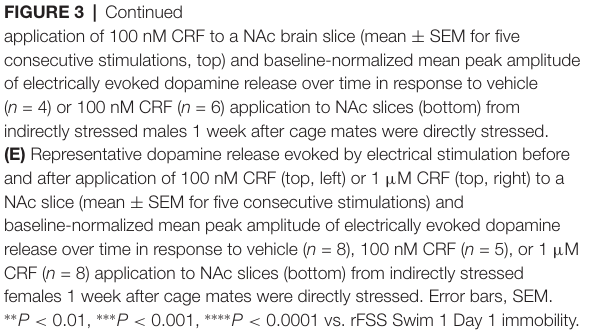
FIGURE 3 | Continued application of 100 nM CRF to a NAc brain slice (mean ± SEM for five consecutive stimulations, top) and baseline-normalized mean peak amplitude of electrically evoked dopamine release over time in response to vehicle ( n = 4) or 100 nM CRF ( n = 6) application to NAc slices (bottom) from indirectly stressed males 1 week after cage mates were directly stressed. (E) Representative dopamine release evoked by electrical stimulation before and after application of 100 nM CRF (top, left) or 1 µ M CRF (top, right) to a NAc slice (mean ± SEM for five consecutive stimulations) and baseline-normalized mean peak amplitude of electrically evoked dopamine release over time in response to vehicle ( n = 8), 100 nM CRF ( n = 5), or 1 µ M CRF ( n = 8) application to NAc slices (bottom) from indirectly